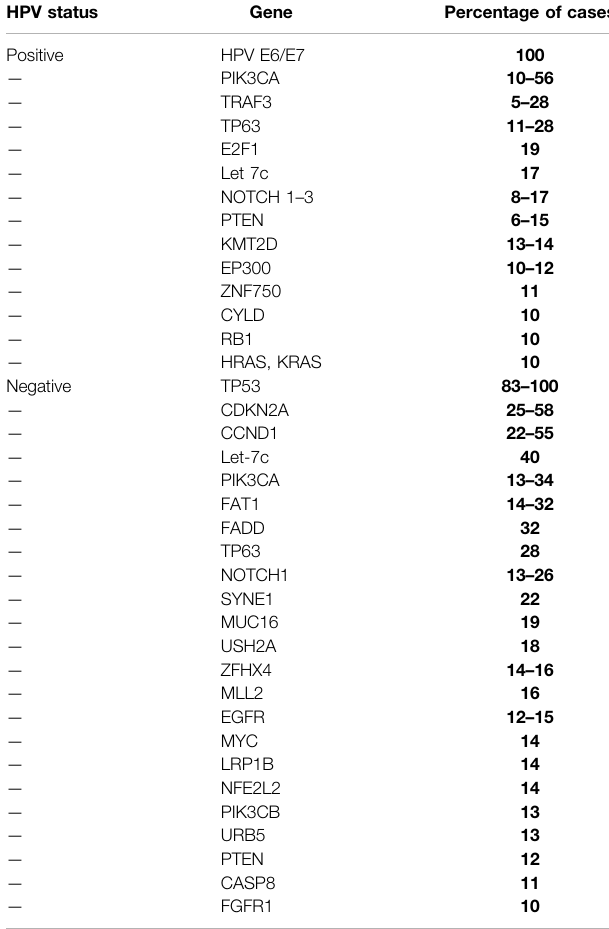
TABLE 1 | Most frequent mutations identi fi ed in HPV positive and negative head andnecksquamouscellcarcinomas(Gillisonetal.,2000;Agrawaletal.,2011; Stransky et al., 2011; Nichols et al., 2013c; Lechner et al., 2013; Pickering et al., 2013; Grønhøj Larsen et al., 2014; Cancer Genome Atlas Network, 2015; Rusan et al., 2015; Seiwert et al., 2015; Beck and Golemis, 2016; Chau et al., 2016; Marur and Forastiere, 2016; Hajek et al., 2017; Chen et al., 2018; Harbison et al.,